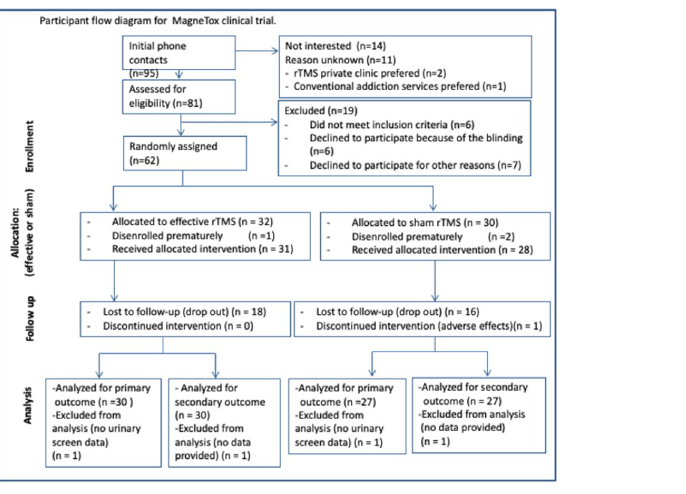
Fig 1. Participant flow